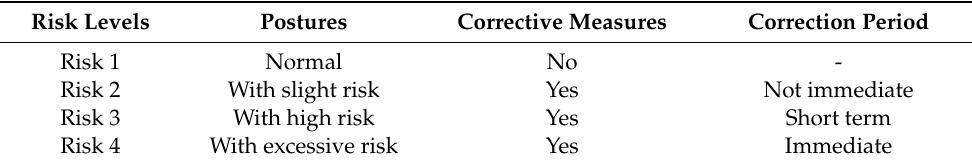
Table 2. OWAS method risk levels